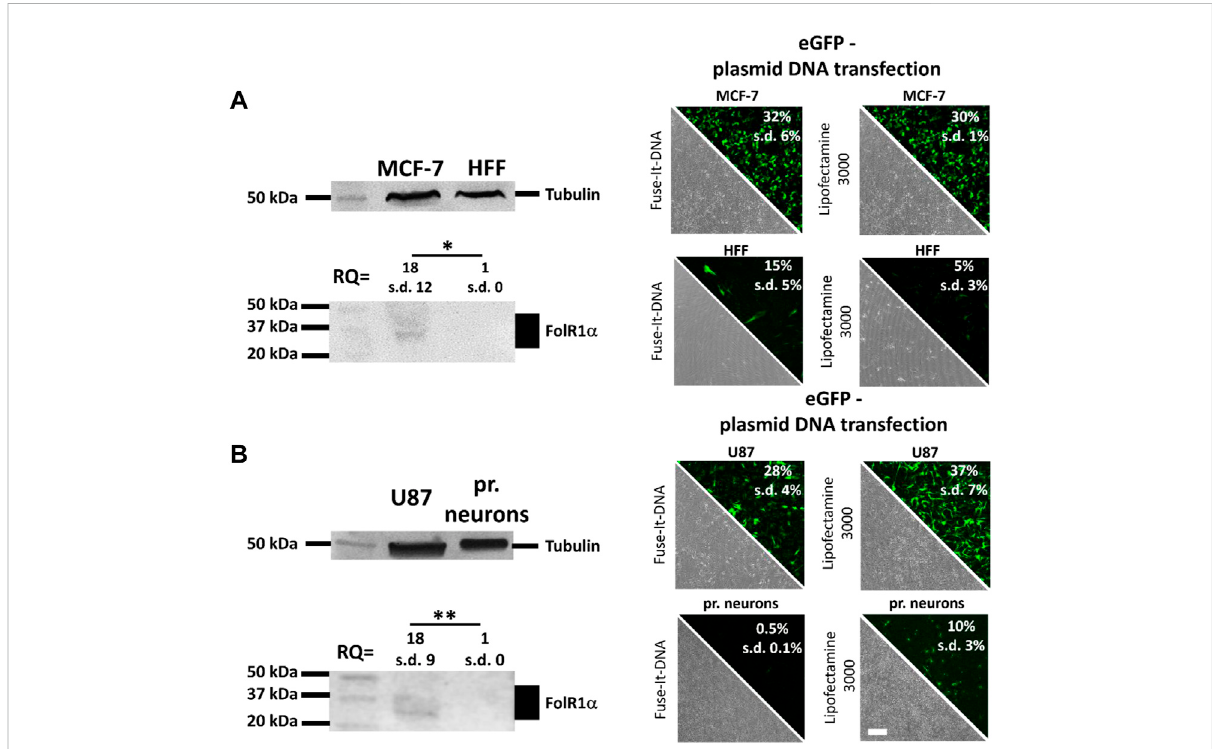
FIGURE 1 Quanti fi cation of folate receptor one alpha (FolR1 α ) protein levels and DNA transfer into healthy and cancer cells. FolR1 α was quanti fi ed by western blot in MCF-7 breast cancer cells and healthy primary human fi broblasts (HFF) (A) as well as U87 glioblastoma cells and healthy primary cortical neurons (B) . The relative quantities (RQ) were adjusted to tubulin and the resulting ratios were analyzed for signi fi cance. For all cell types, transfection ef fi ciency was determined using Fuse-It-DNA and Lipofectamine ® 3000 with transfer of an eGFP encoding plasmid. Results were recorded by fl uorescence microscopy (phase contrast and eGFP channel) and fl ow cytometry. Scale bar 200 μ m. n = at least three independent